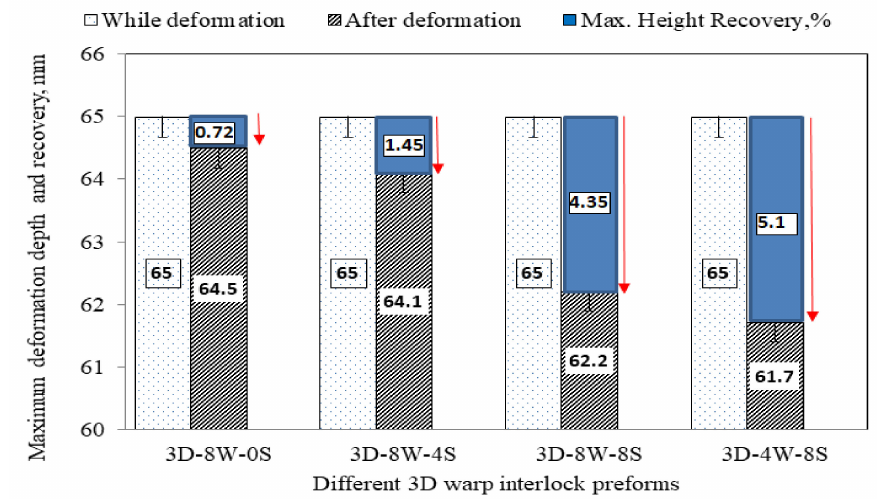
Figure 15. Molding recovery at maximum depths of the di ff erent